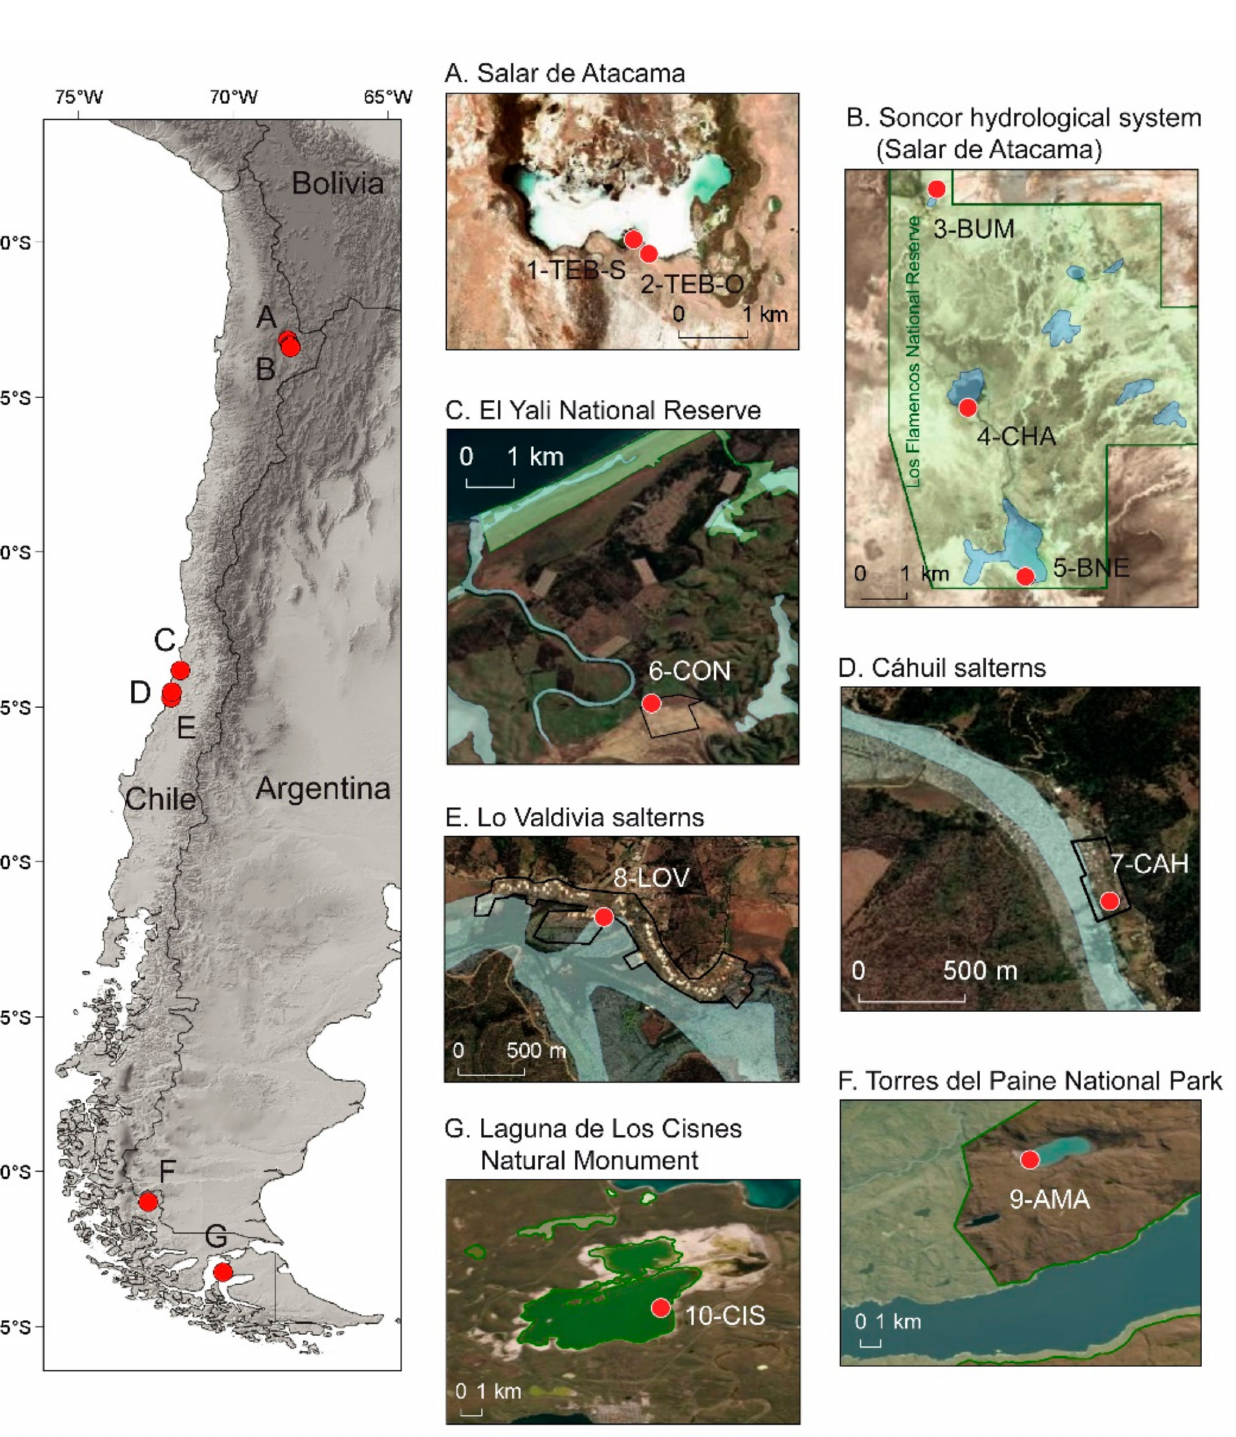
Figure 1. Geographical localisation of study sites along Chile including lagoons from Salar de Atacama in the north ( A , B ), coastal artificial salterns in the centre ( C – E ) and Patagonian lagoons in the south ( F , G ). Images correspond to close-ups of these seven sampling areas indicating the wetlands where Artemia was collected. 1-TEB-S, Tebenquiche-sendero; 2-TEB- O, Tebenquiche-origen; 3-BUM, Burro Muerto pond; 4-CHA, Chaxas lagoon; 5-BNE, Barros Negros lagoon; 6-CON, El Convento salterns; 7-CAH, C á huil salterns; 8-LOV, Lo Valdivia salterns; 9-AMA, Amarga lagoon; 10-CIS, Cisnes lagoon. Protected areas Los Flamencos National Reserve , El Yali National Reserve , Torres del Paine National Park and Laguna de Los Cisnes Natural Monument in ( B , C , F , G ), respectively, are delimited by continuous green lines. Red dots indicate collection